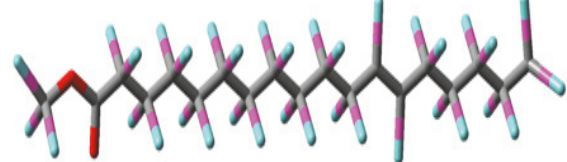
Figure 5: 3D 12-Octadecenoic acid, methyl ester compound struc- ture of Erythrina variegata leaf methanol